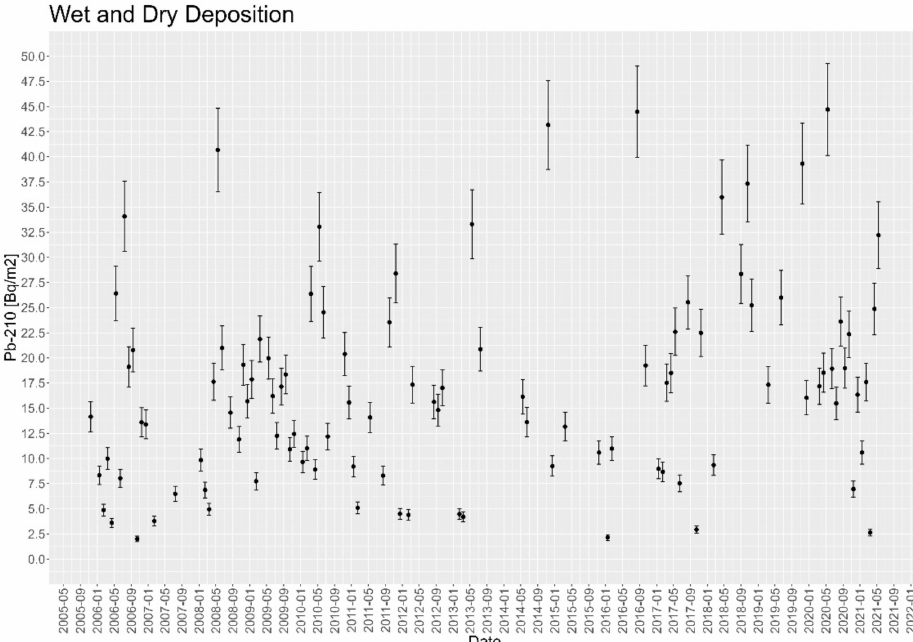
Figure 5. 210 Pb wet and dry deposition data from 2005 to 2021, with their uncertainties (2 σ ). The lowest measured value was 2.0 Bq/m 2 while the maximum was 44.7 Bq/m 2 ,